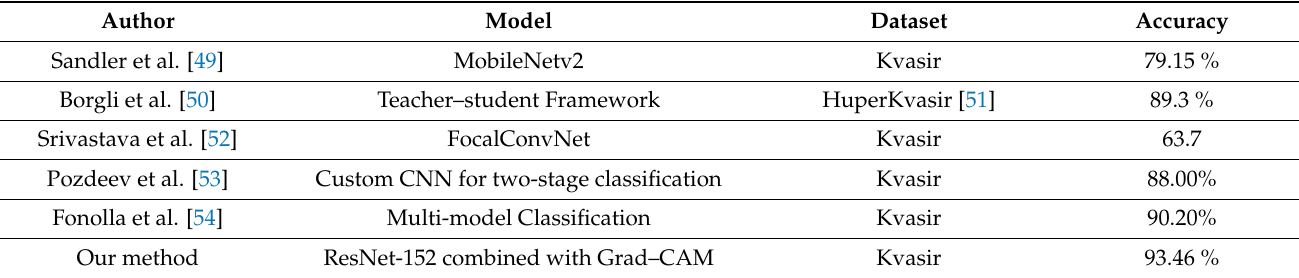
Table 4. The results of comparison